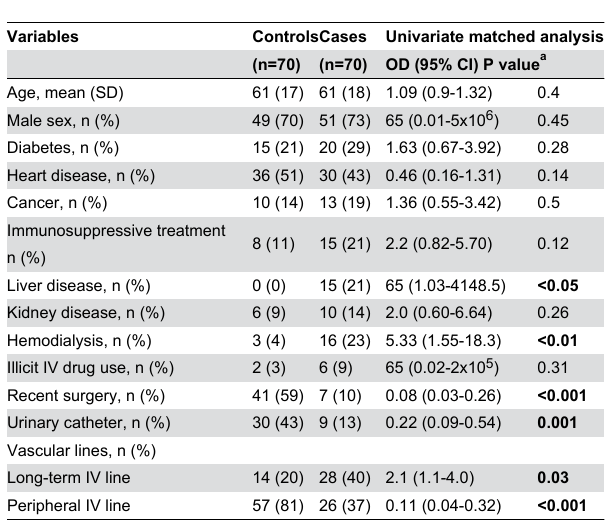
Table 3. Analysis of MBL2 and NOD2 genotypes in S. aureus BSI cases and controls.